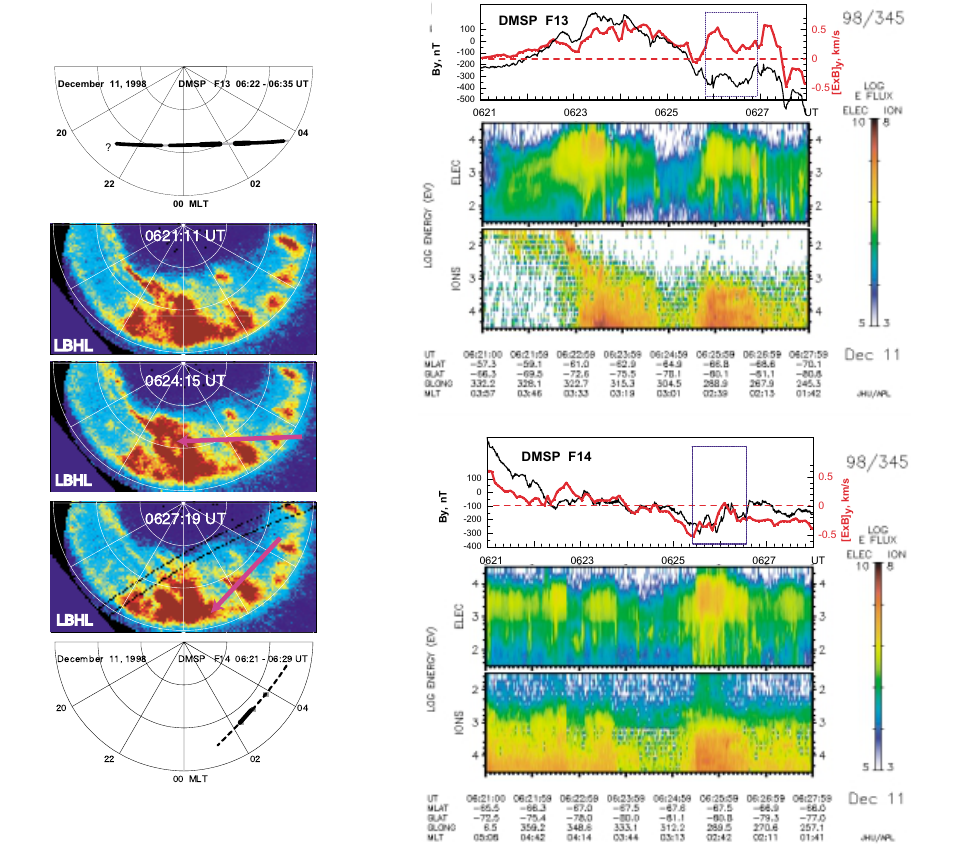
Fig. 5. Summary of DMSP F13/F14 observations during the crossing of touch-like structure (old streamer) at ∼ 06:26